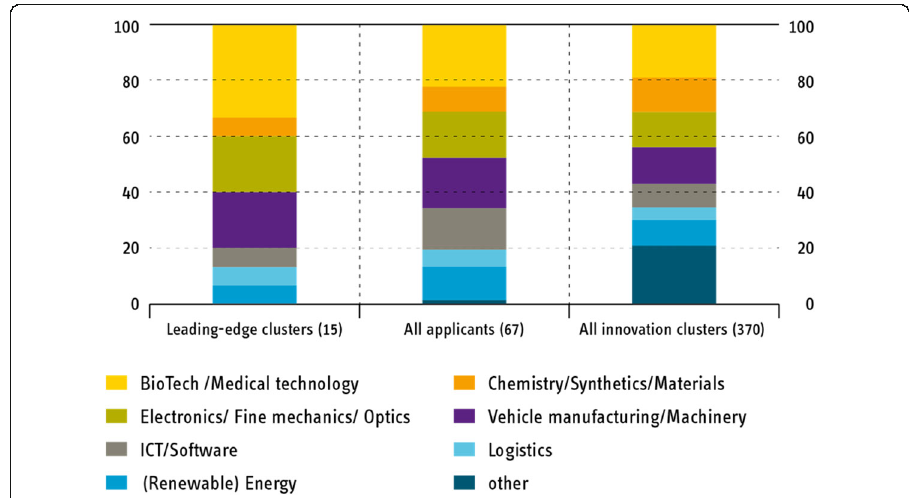
Fig. 3 Industry distribution of the cluster initiatives in comparison. Source: Accompanying evaluation of the LECC, based on an own inquiry (date: November 2013). The LECC had an above average number of applications from cluster initiatives in the fields of biotechnology and medical technology. A possible cause may be that several funding programmes for networks and clusters in this industry have been conducted in the past (e.g. BioRegio), which led to the development of structures that were beneficial in the LECC candidacy. This is true not only for the group of candidates, but even more for successful initiatives: The share of biotechnology and medical technology clusters is even higher in the 15 Leading-Edge Clusters